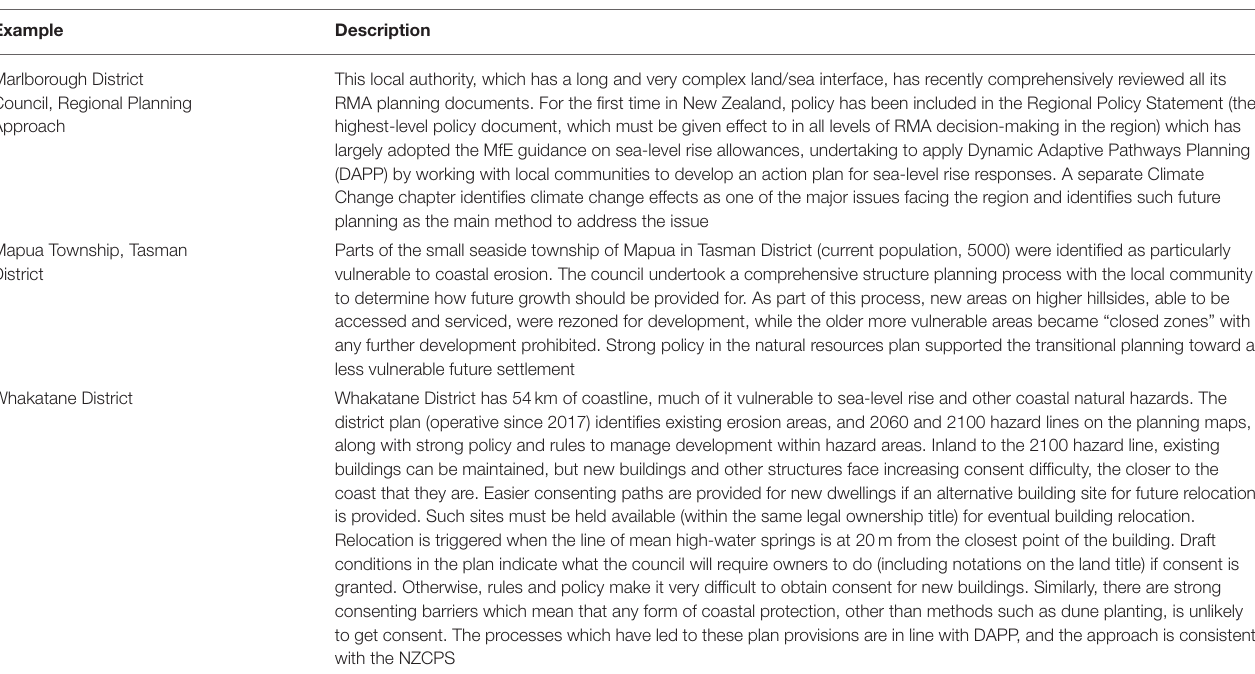
TABLE 2 | Examples of proactive planning that will reduce risk over